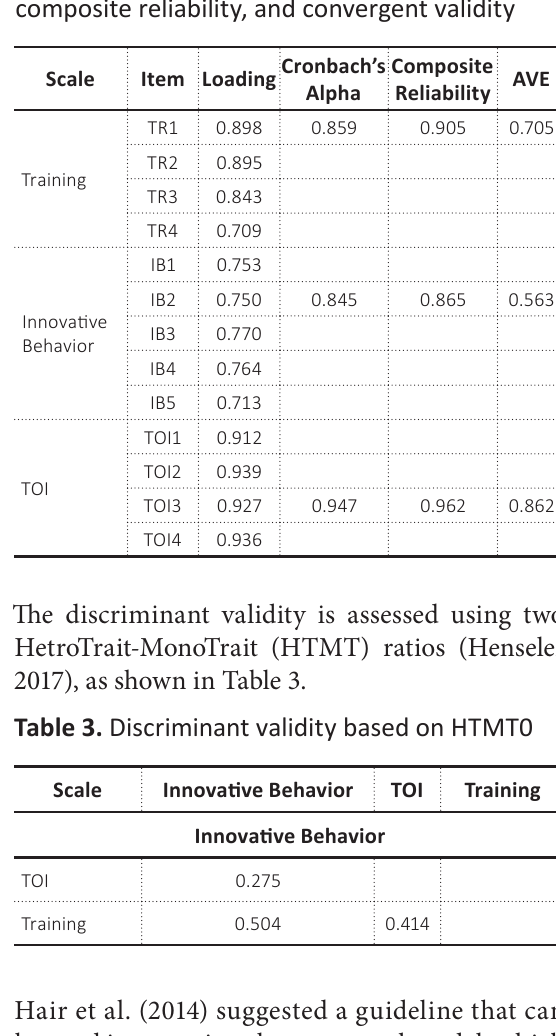
Table 2. Factor loadings, Cronbach’s alpha,